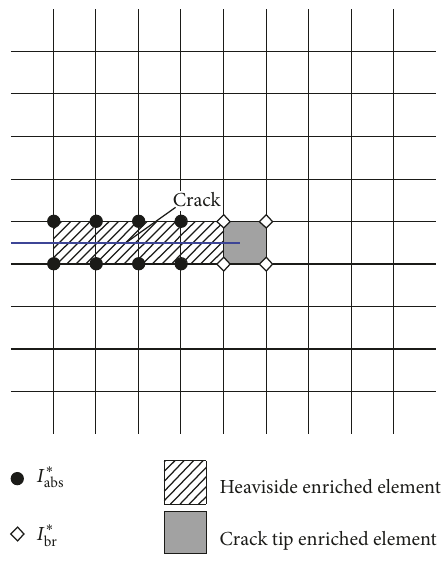
Figure 1: A strategy for enriched elements and